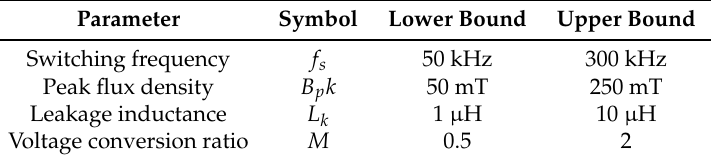
Table 2. Lower and upper bounds for genetic algorithm.